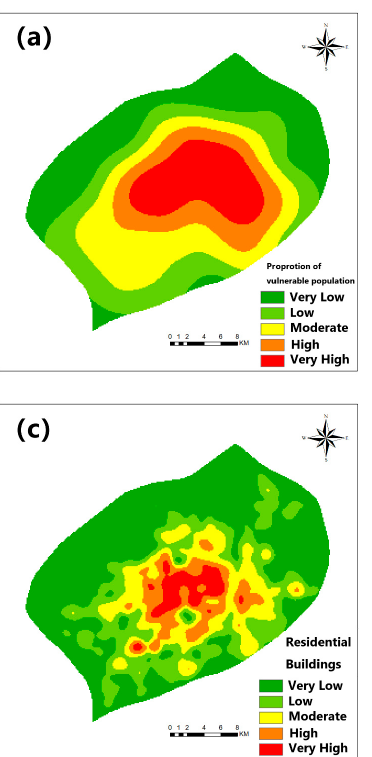
Figure 5. Proportion of vulnerable population ( a ); commercial buildings ( b ); residential buildings ( c